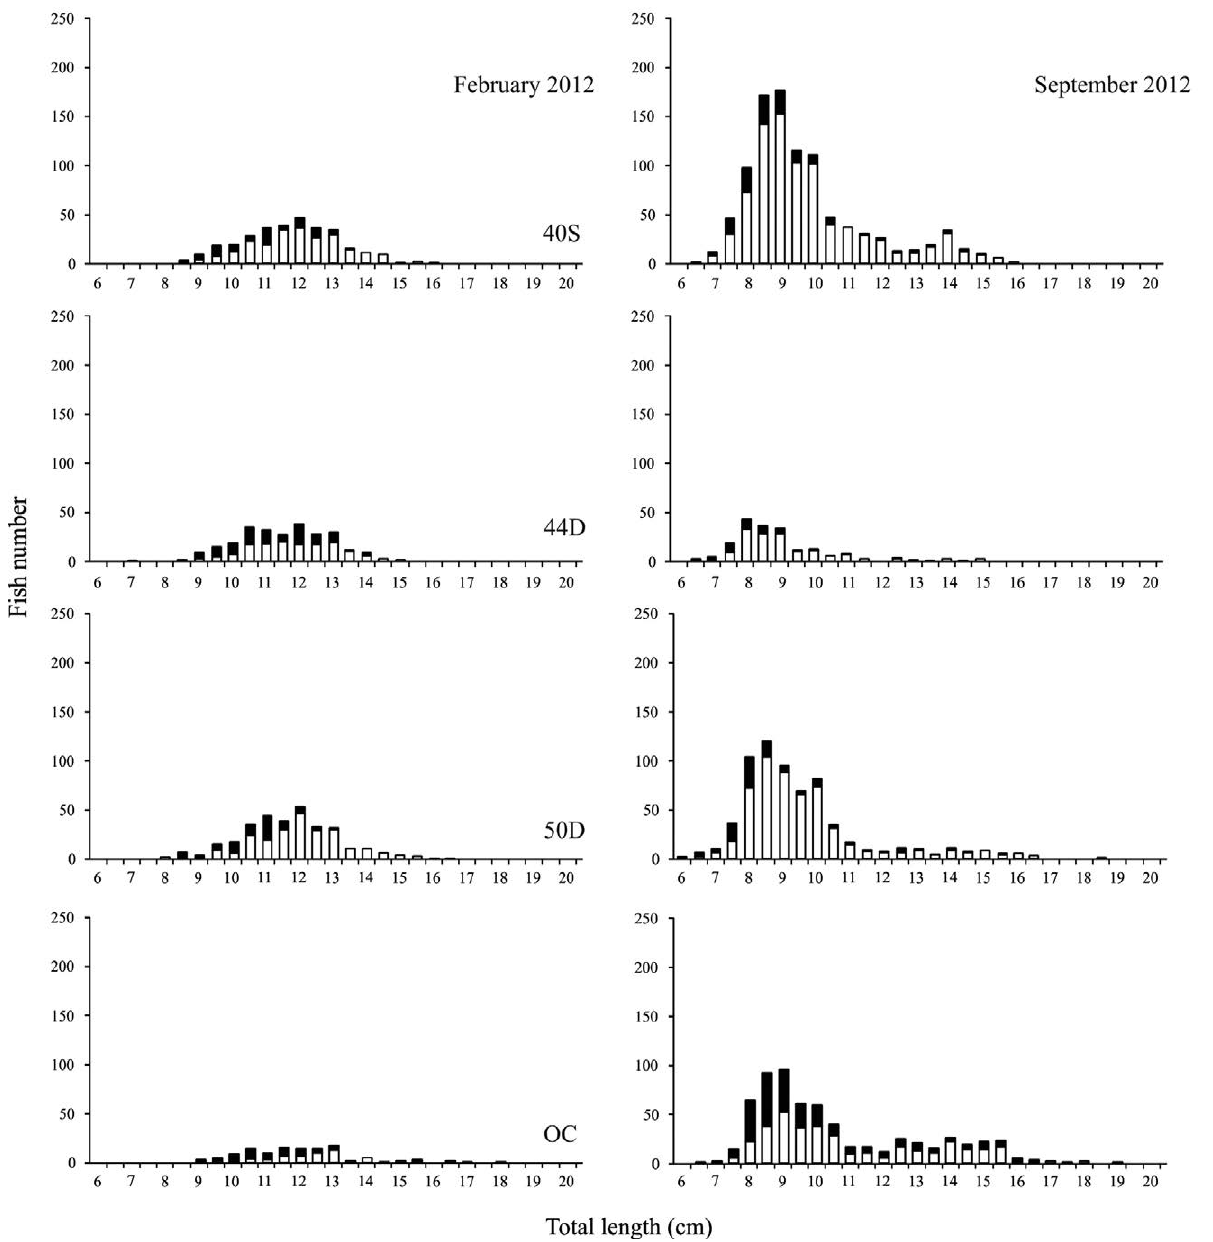
Fig. 4. – Red mullet. Number of dead fish (black) and survivors (white) in each length class for test and open codend cages in winter and summer of